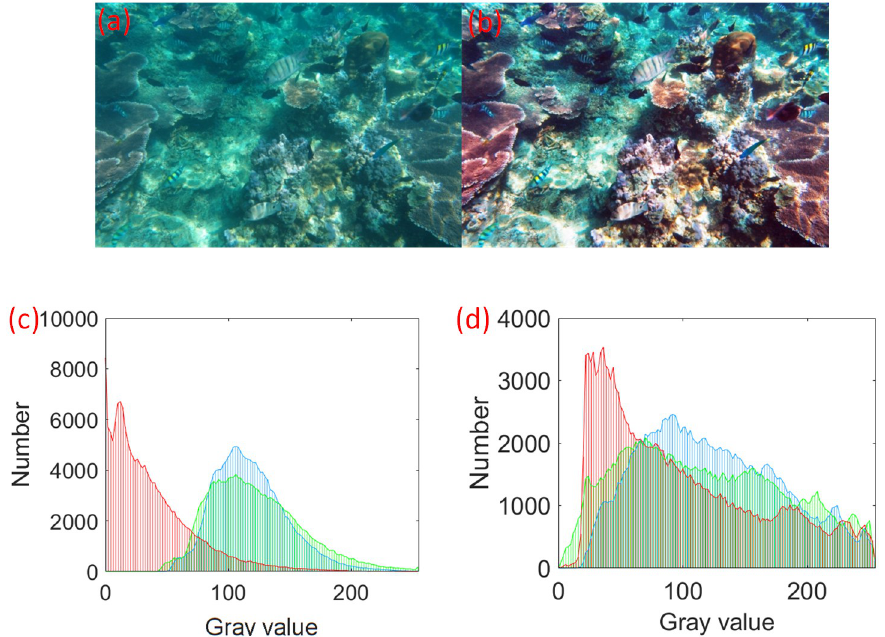
Fig 4. Contrast image and RGB three-channel histogram. (a) Original; (b) Contrast enhancement; (c) Original histogram; (d) Histogram after contrast enhancement.